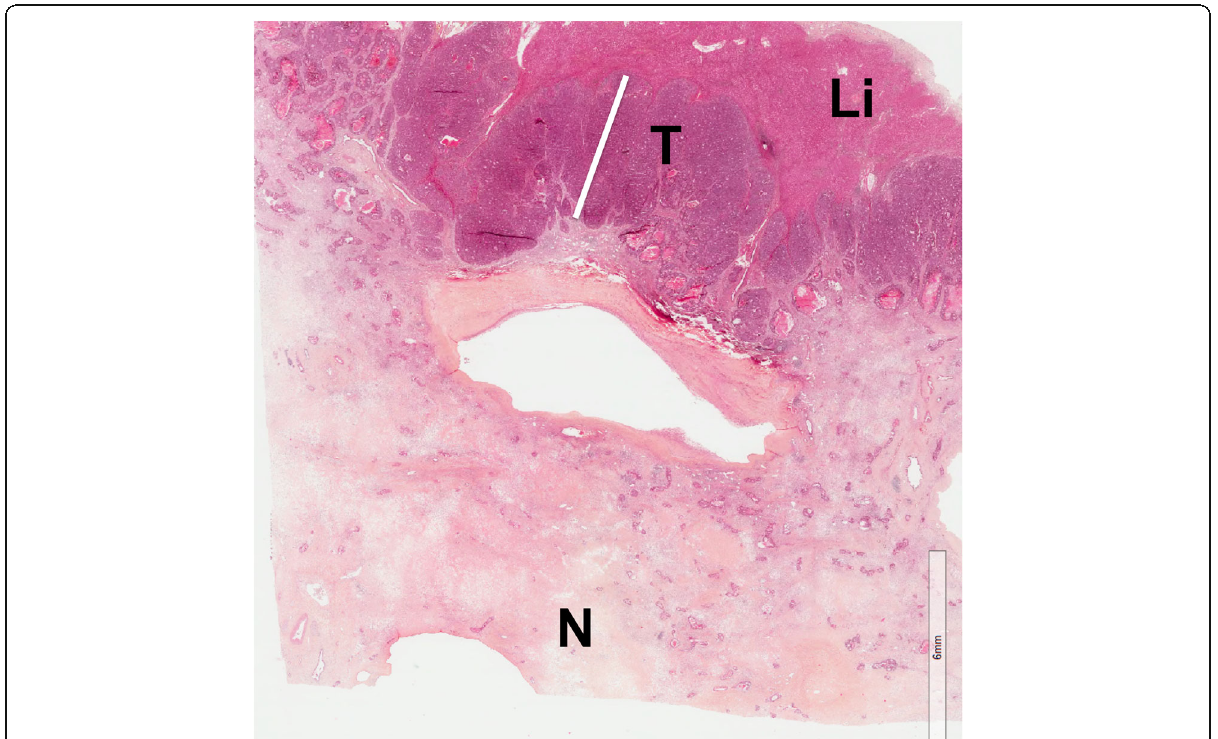
Fig. 10 Illustration of tumor/normal liver interface on histology (TNI). White line illustrates the measurement of the thickness of tumor cells at the interface between the viable tumor cells (T) and the liver parenchyma (Li), corresponding to the TNI. In this case, TNI was 4 mm. Note the presence of diffuse necrosis